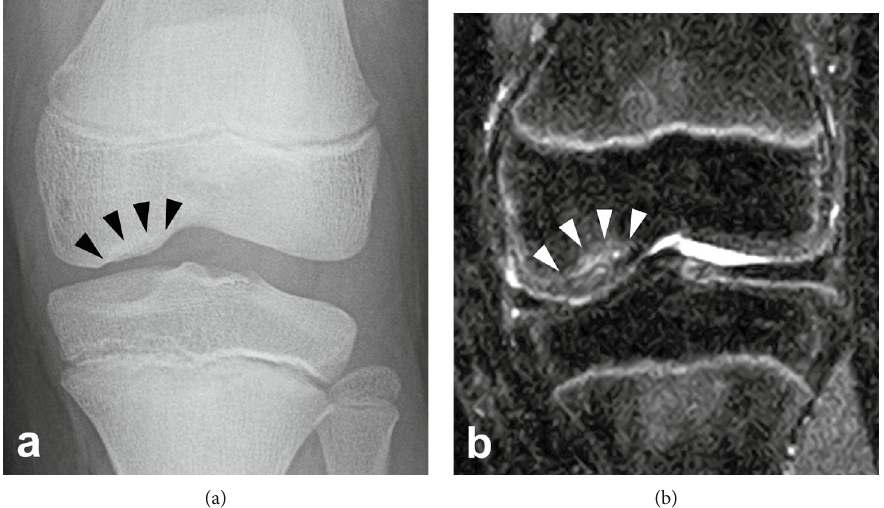
Figure 1: (a) Radiograph of the left knee showing Brückl ’ s stage III OCD lesion in the MFC. (b) Short T1 inversion recovery (STIR) sequence MRI coronal image of the left knee indicating Nelson ’ s stage II lesion in the MFC.